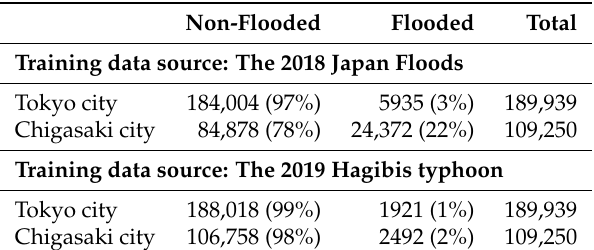
Figure 5. ( a – c ) Predicted flood map computed from the discriminant function f 2018 . ( a ) Predictions at the PR1, PR2, and PR3 test areas. ( b ) Closer look at around the Tokyo Imperial Palace. ( c ) Closer look at a residential area. ( d , e ) Predictions computed from the discriminant function f 2019 . Table 2. Predictions in non-flooded